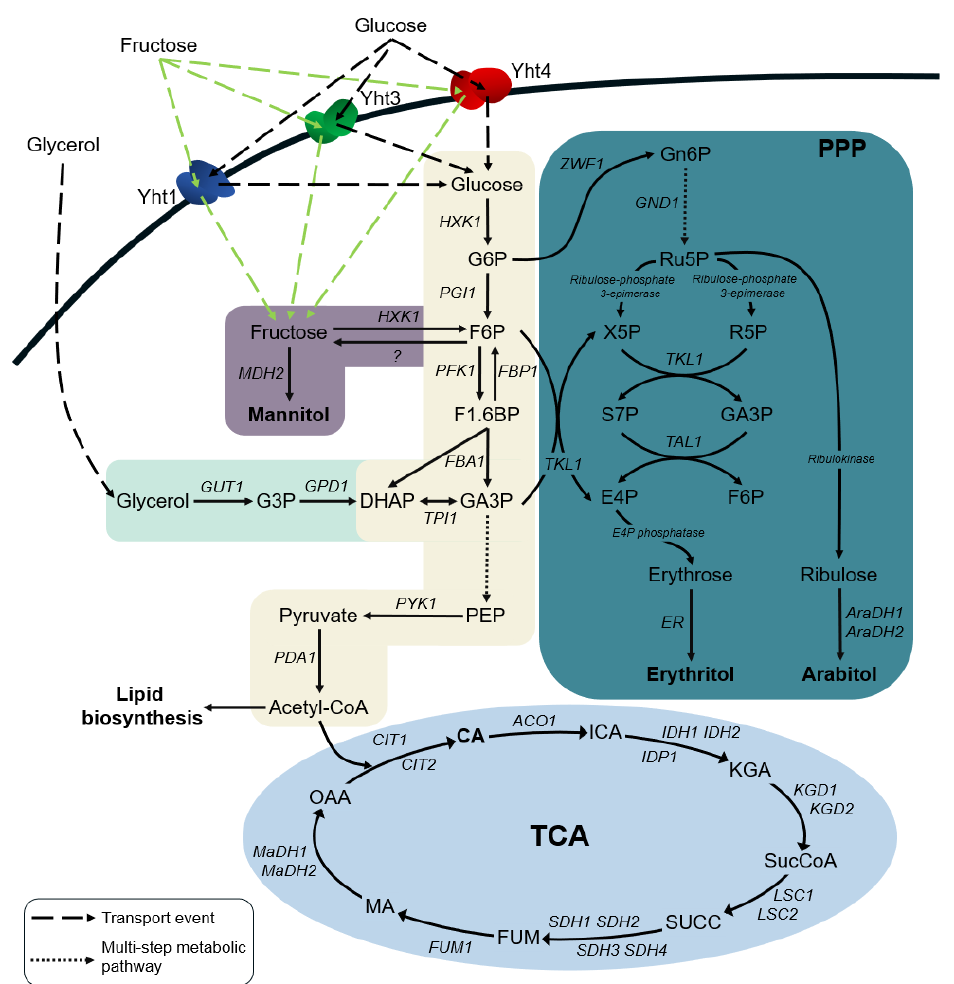
Figure 5. Simplified schematic representation of the metabolic pathways for polyol and CA biosynthesis in the yeast Y. lipolytica . Abbreviations: CA—citric acid; DHAP—dihydroxyacetone phosphate; E4P—erythrose 4-phosphate; F1.6BP—fructose 1.6-bisphosphate; F6P—fructose 6-phosphate; FUM—fumaric acid; G3P—glycerol 3-phosphate; G6P—glucose 6-